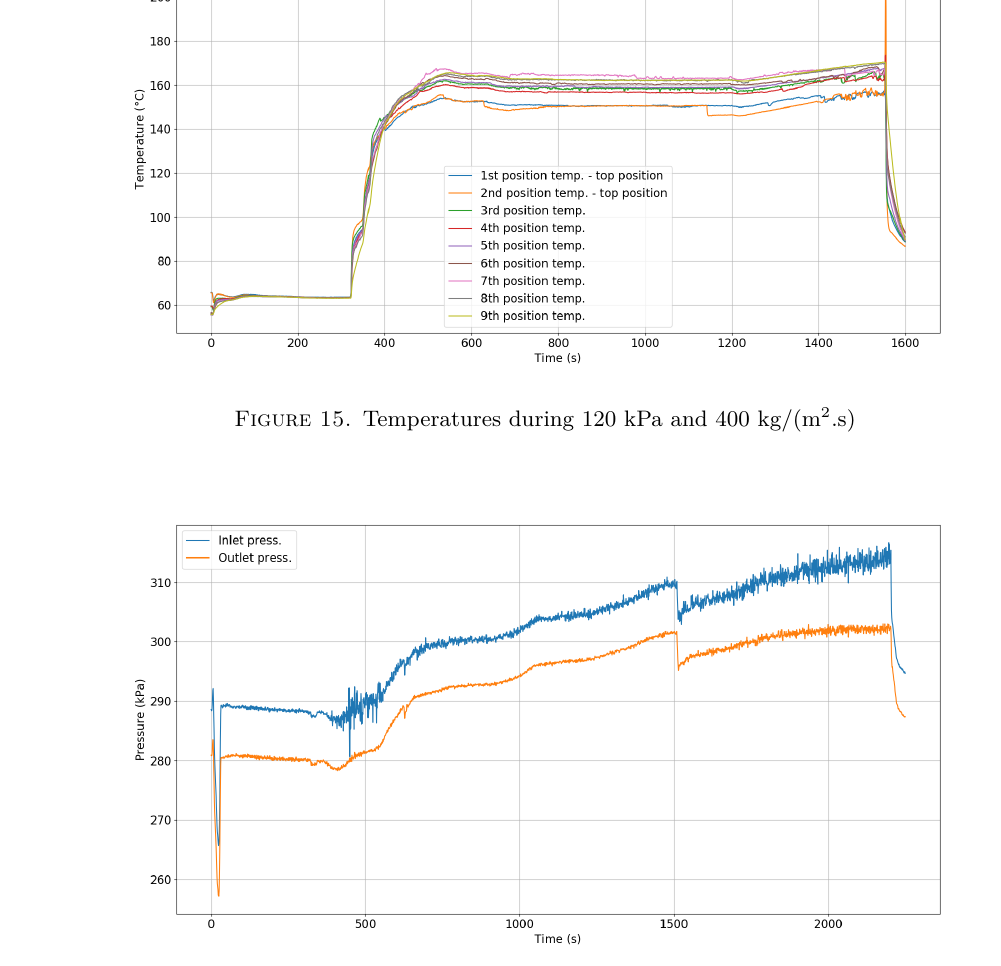
Figure 16. Pressures during 300 kPa and 400 kg/(m 2 .